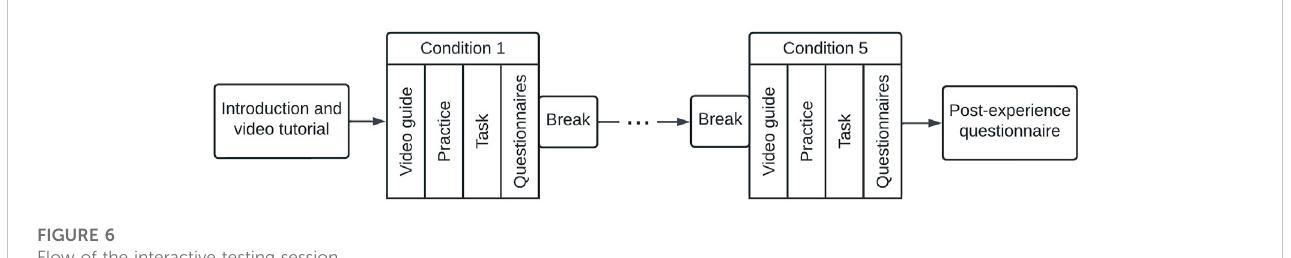
FIGURE 6 Flow of the interactive testing session.